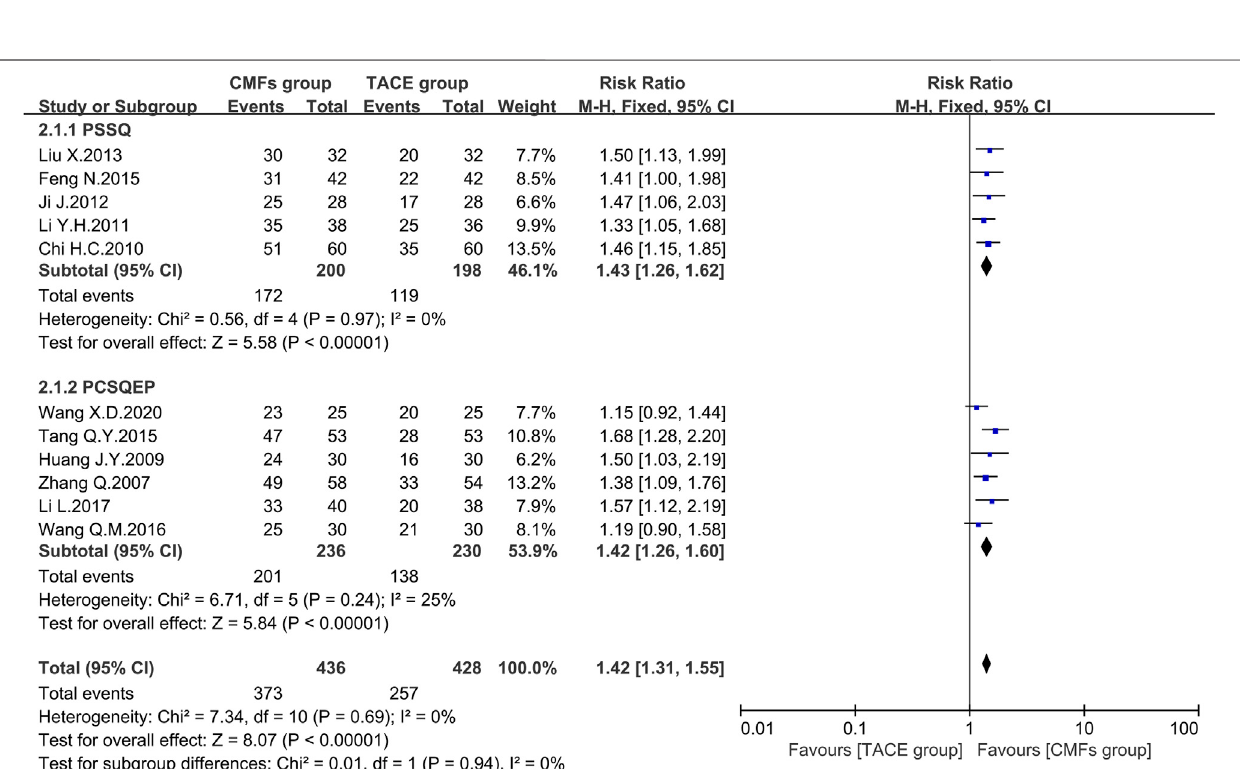
tumors shrank to a certain level and remained there for a certain period, was taken as an outcome indicator. A total of 12 clinical trials applied WHO criteria, and the results showed a more